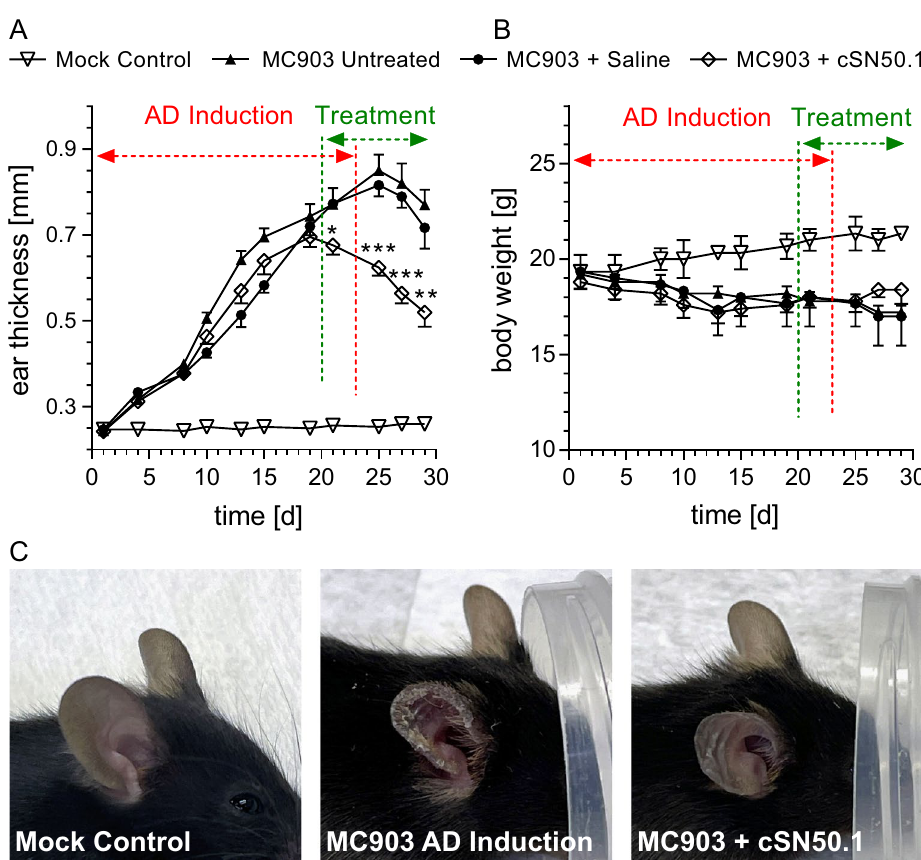
Figure 2. NTCI treatment reduces signs of MC903-induced Atopic Dermatitis (AD)-like phenotype manifested by swelling, redness, and scaling. Topical NTCI treatment accelerates healing in an experimental model of AD-like phenotype. Cardinal signs of inflamed skin, swelling (A), and redness and scaling (C) were significantly reduced by topical application of cSN50.1 peptide. ( A ) Ear thickness data is displayed as mean ± S.E.M. (n = 3 for Mock Control and n = 10 for all other conditions). Statistical significance of the difference between ear thickness in NTCI-treated mice (MC903 + cSN50.1) and untreated (MC903 Untreated) or saline-treated (MC903 + saline) groups was determined by two-way ANOVA using corrected Holm-Sidak test for multiple comparison, * p < 0.05, ** p < 0.005, *** p < 0.0005. ( B ) Body weight was not significantly affected by MC903 challenge, NTCI, or by saline treatment albeit body weight gain was arrested in these groups. ( C ) Representative pictures of mice from the Mock Control group taken at the end of experiment and from the cSN50.1-treated group immediately before (MC903 AD Induction) and after NTCI treatment (MC903 +